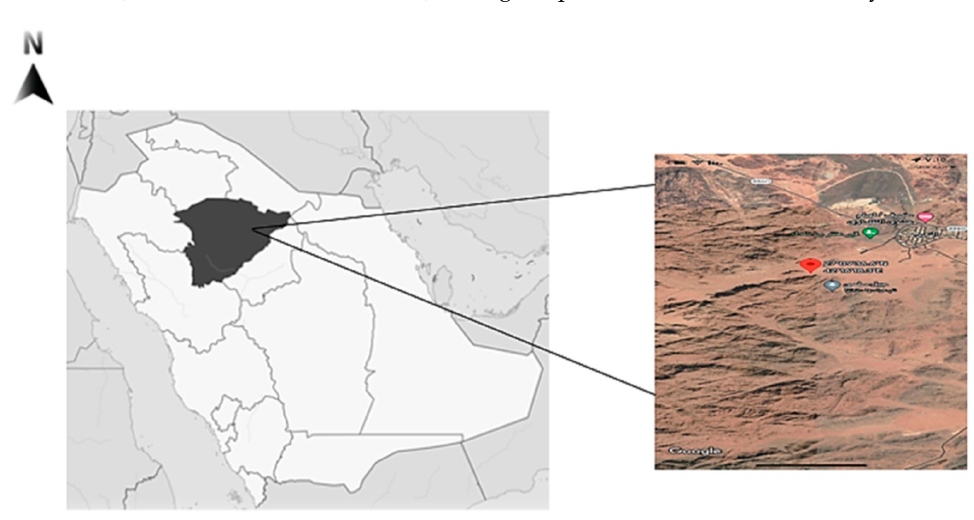
Figure 4. Map of Saudi Arabia showing the collection area of Fogonia indica.